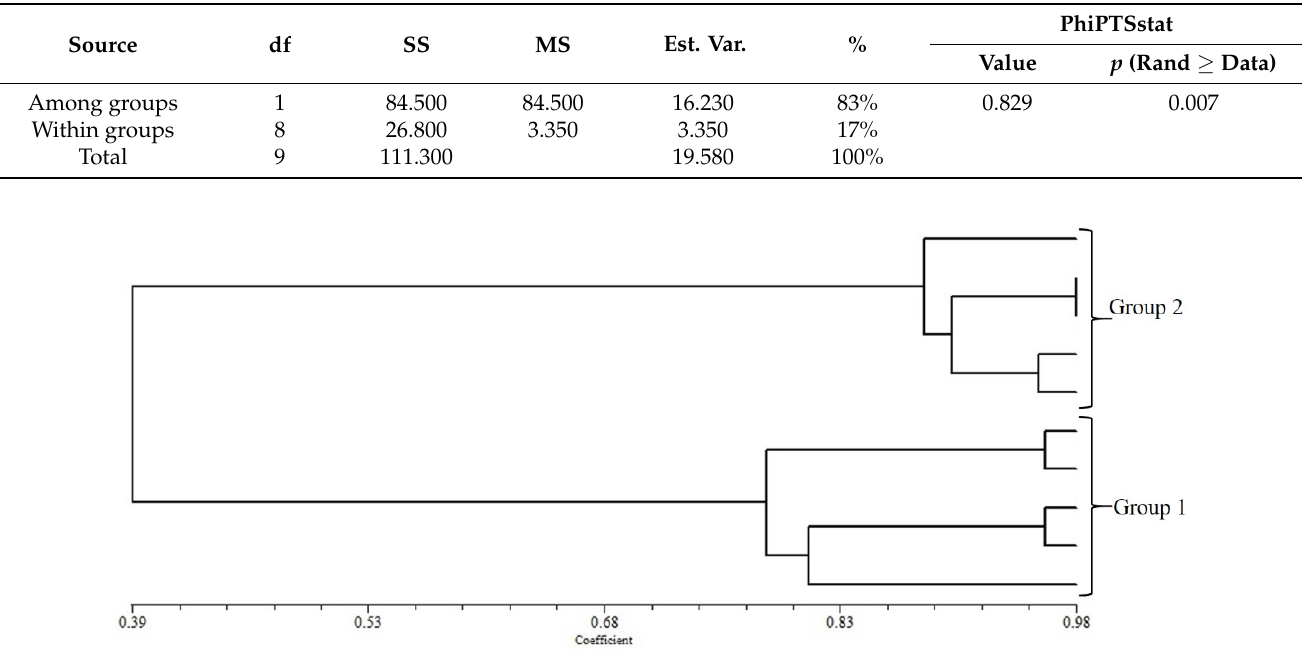
Figure 7. Result of the genetic similarity of two groups of J. seravschanica (group 1; trees with dried branches), (group 2; trees without dried branches).